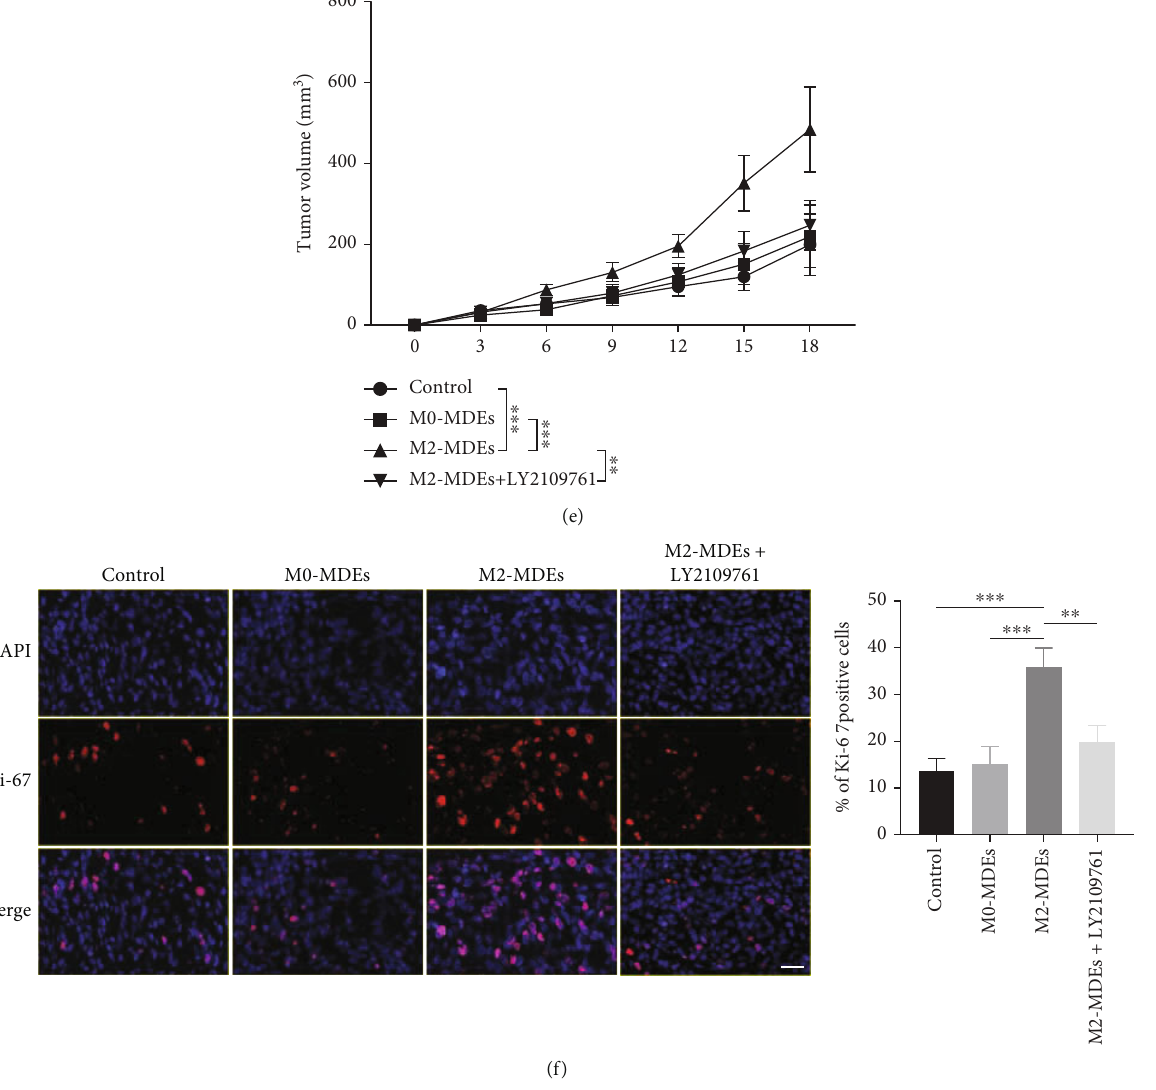
Figure 6: M2-MDEs promote tumorigenesis of meningioma cells in vitro and in vivo. (a) 3D tumorspheres formed in vitro by meningioma cells cocultured with MDEs. Scale bar 200 μ m. (b) Measurement and statistical analysis of the volume of 3D tumorspheres. (c) Labeling of proliferating meningioma cells in 3D tumorspheres with EdU staining and detection of EdU + cell ratio by fl ow cytometry. (d, e) Dissection of subcutaneous xenografts and measurement of tumor volume. (f) Proliferating cells were identi fi ed by immuno fl uorescence using antibody against Ki-67. Tumor proliferative activity was evaluated by calculating the proportion of Ki-67 + cells. ∗ p < 0 : 05 , ∗∗ p < 0 : 01 , ∗∗∗ p < 0 : 001